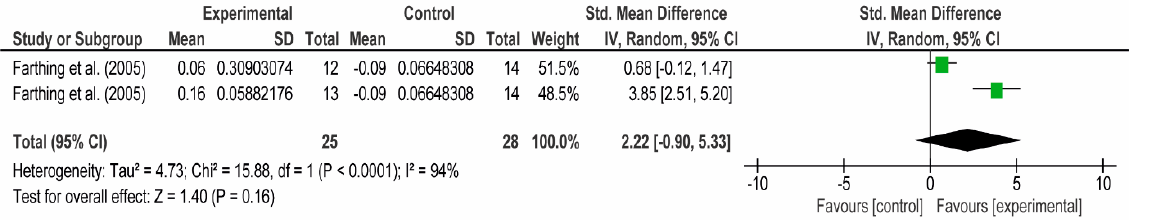
and radialis MT of the trained right and left hands. The first line represents the right hand (dominant)